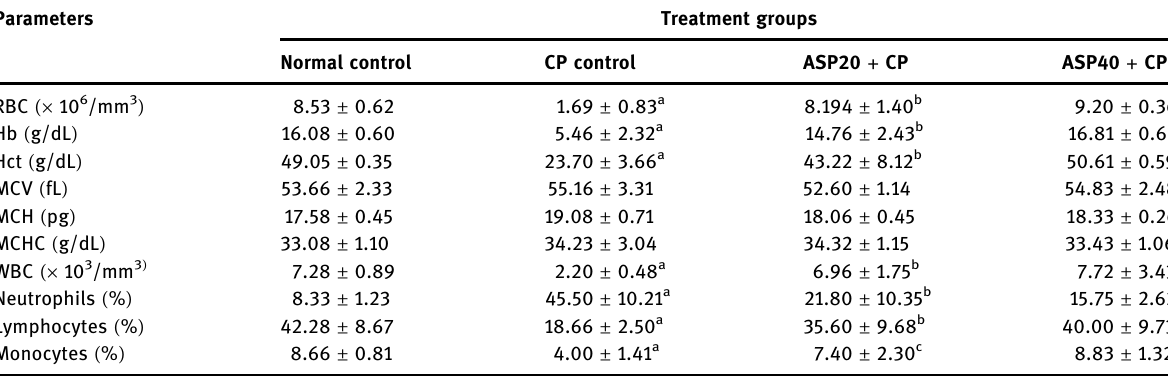
Table 2: E ff ect of ASP on haematological parameters in CP - treated rats Parameters